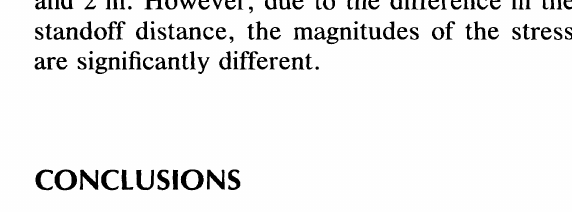
FIGURE 11 As in Fig. 10, but for the sandwich wet